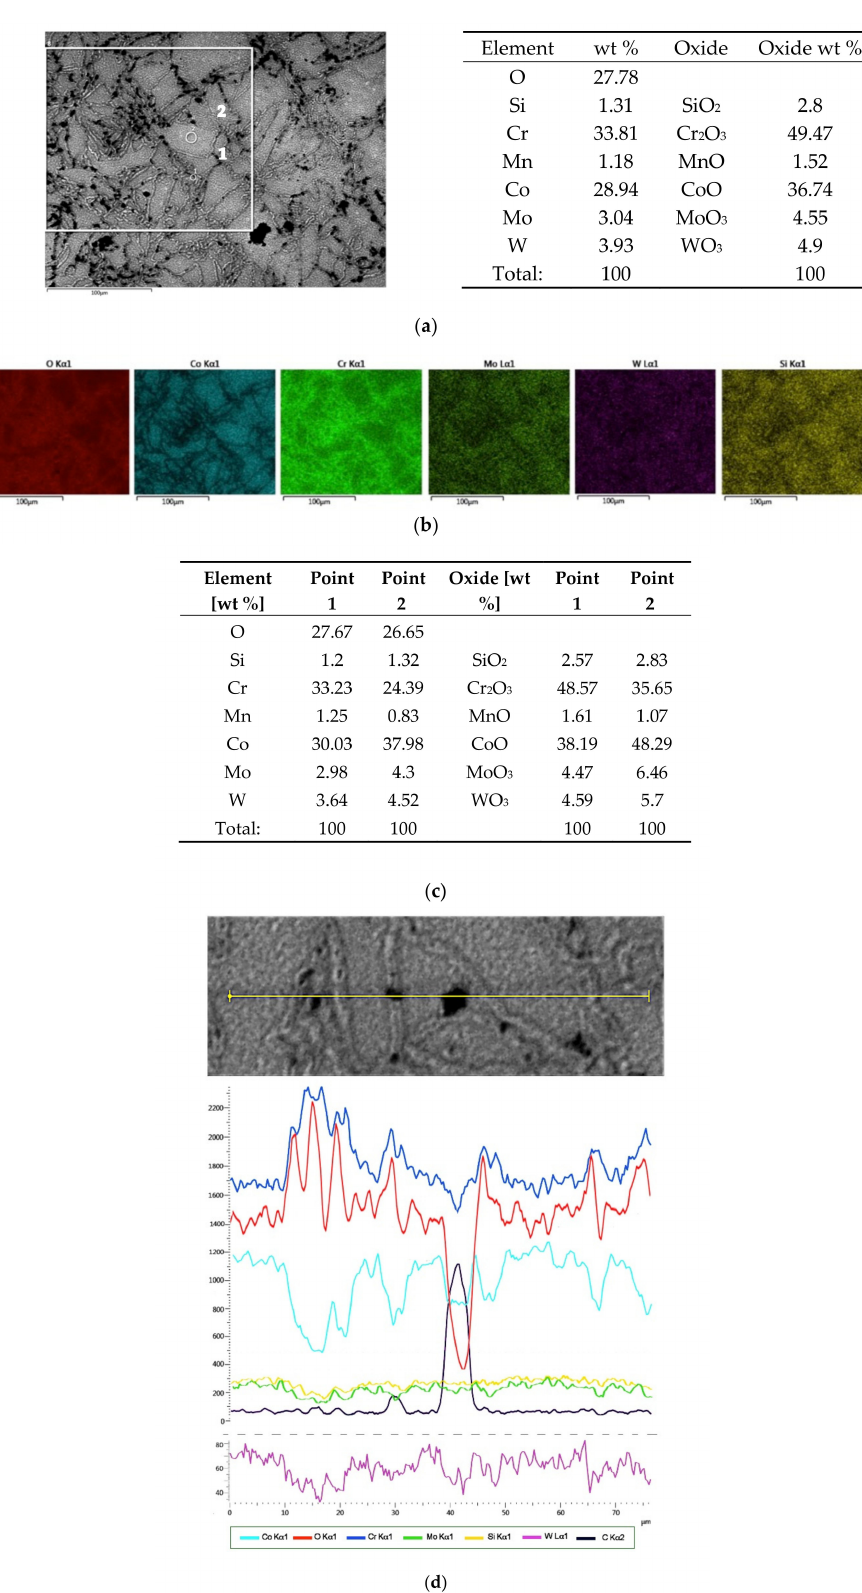
Figure 7. SEM EDS results for the SLM2 sample: ( a ) SEM-SE micrograph showing the morphology with average EDS results from the marked area; ( b ) maps presenting the surface distribution of O, Co, Cr, W, Mo, and Si; ( c ) EDS results for marked points; ( d ) SEM-SE micrograph with corresponding EDS line scan